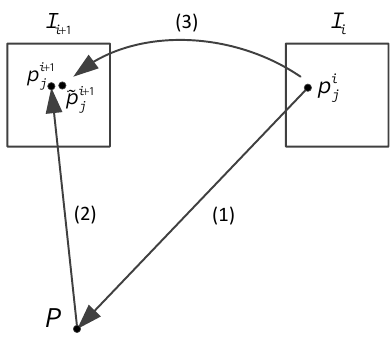
Figure 2. Evaluation method of matching